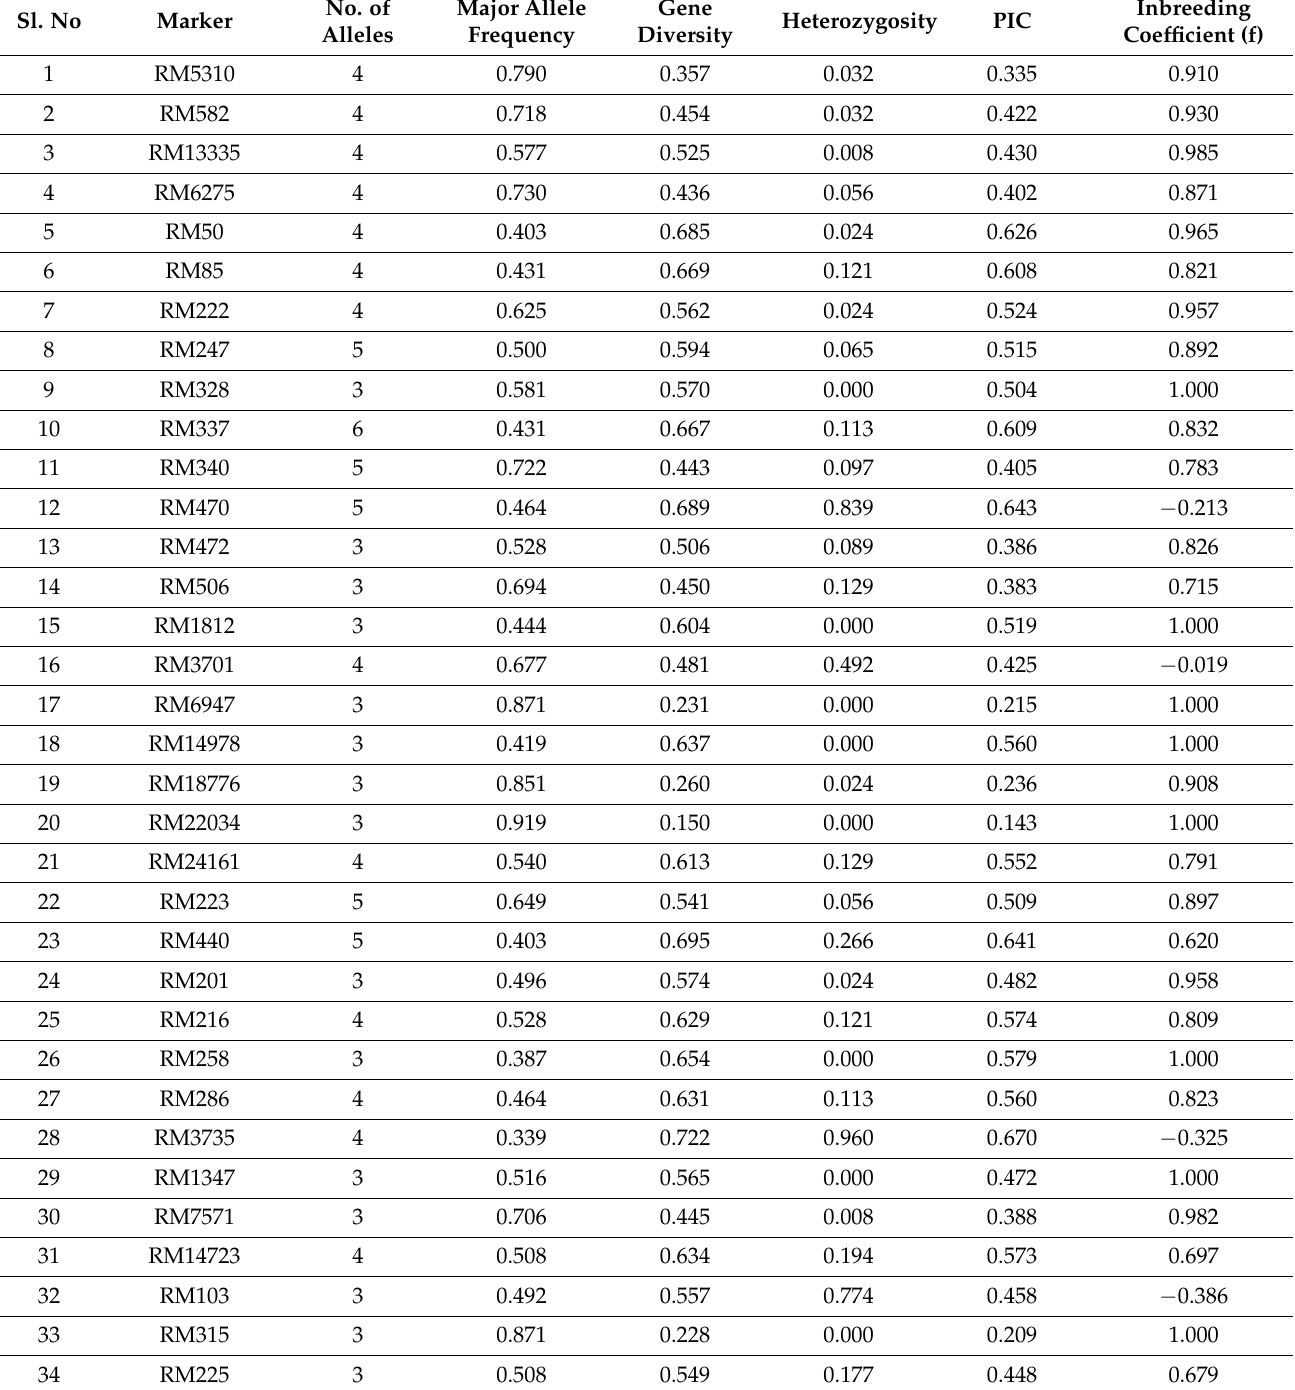
Table 2. Estimation of genetic diversity parameters based on 143 SSR marker loci in a panel containing 124 rice germplasm